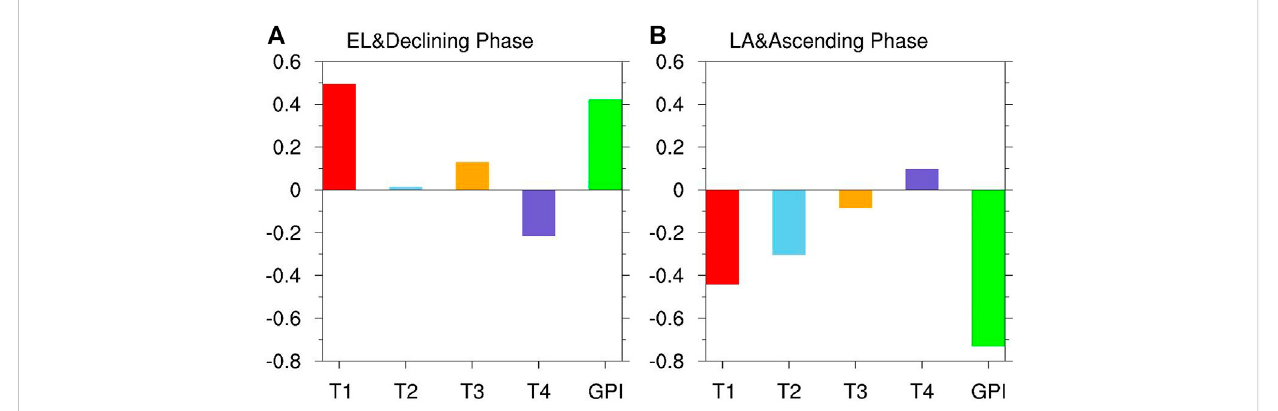
FIGURE 9 Compositeregionalmeanabsolutevorticityterm(T1),verticalwindshearterm(T2),relativehumidityterm(T3),potentialintensityterm(T4),andGPI anomalies in the SEWNP in (A) El Niño years during declining phases of solar cycle and (B) La Niña years during ascending phases of solar